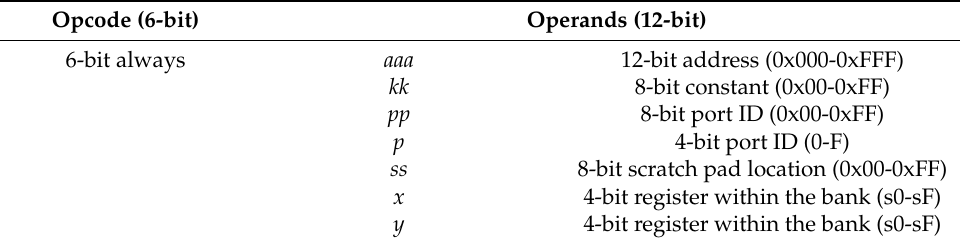
Table 2. PicoBlaze Instruction Bitfields